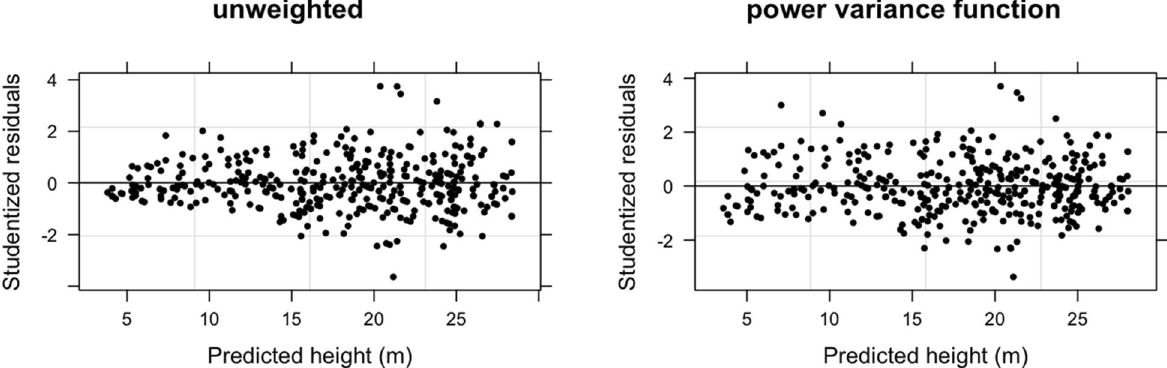
Fig. 12 The plot of studentized residuals against the predicted height for A. araucana . The studentized residuals were obtained by fitting the simple NLME H–D model for AA without weighting (left) and with power variance function (right)